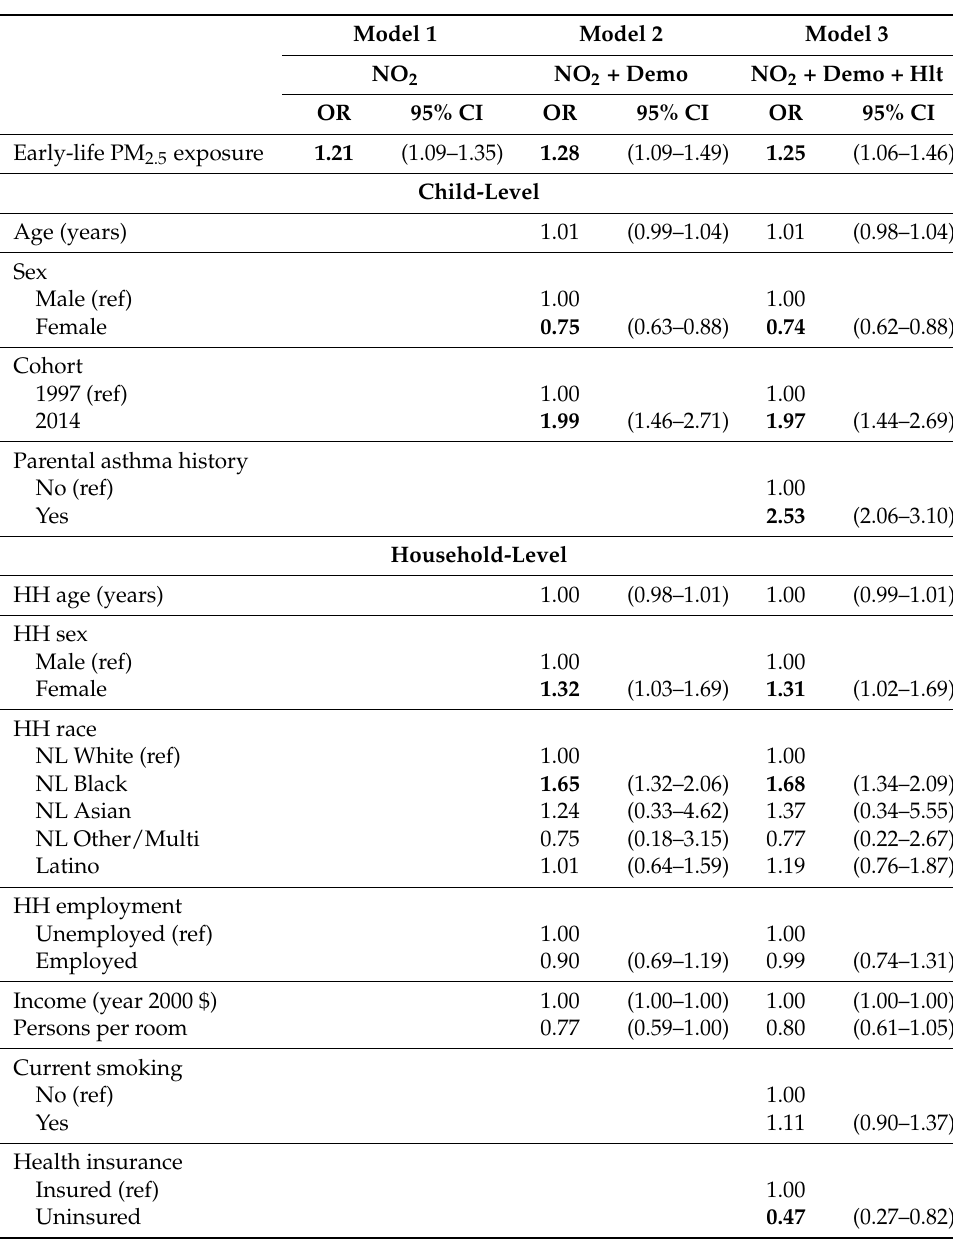
Table 3. Association of early-life PM 2.5 exposure with childhood asthma risk, PSID-CDS, 1990–2014 ( N =